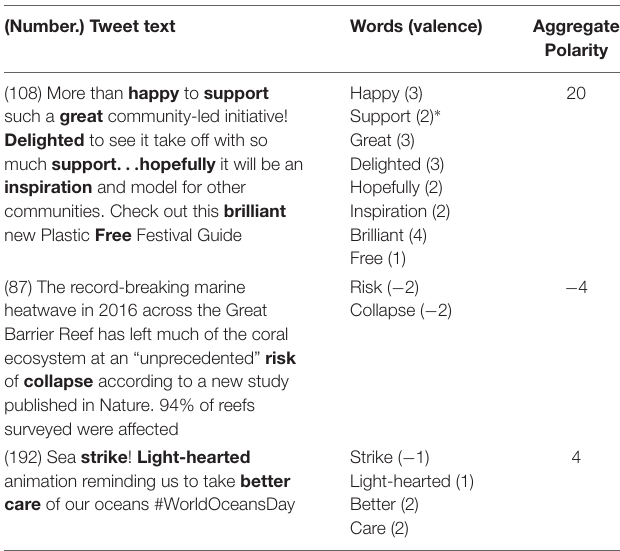
TABLE 2 | Sample tweets demonstrating the AFINN sentiment score methodology. Example tweets and corresponding sentiment scores (Number.) Tweet text